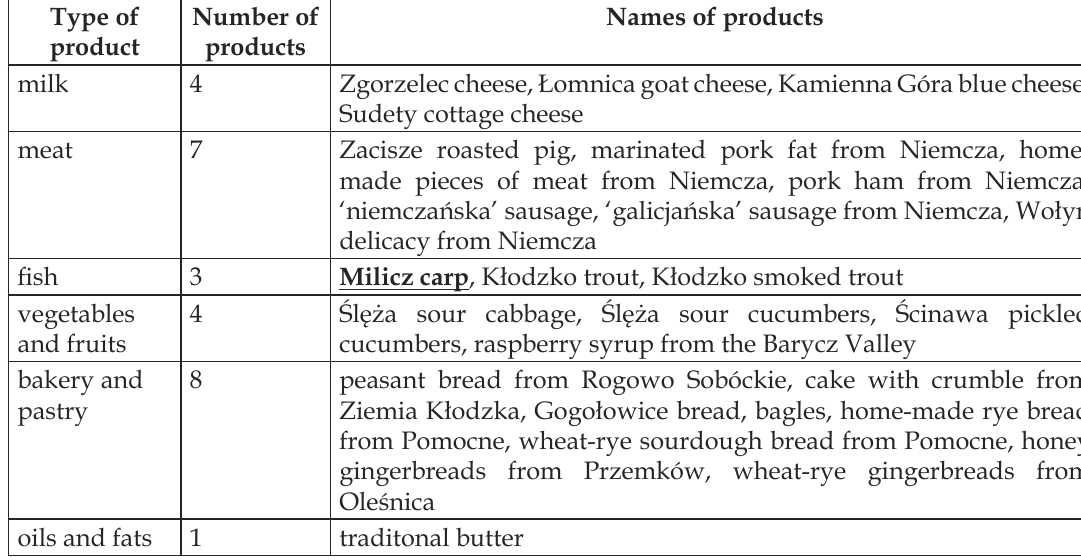
Tab. 2. Traditional products from Lower